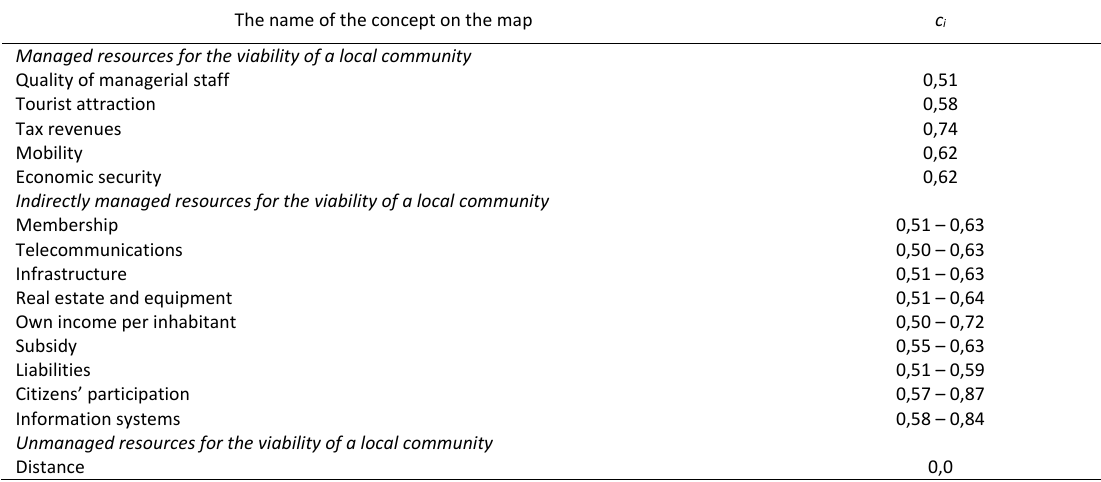
Table 2: Grouping of resources for the viability of a local community according to its manageability The name of the concept on the map